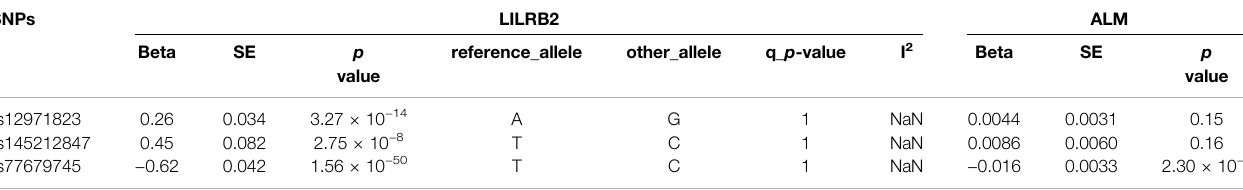
TABLE 1 | Correlation of genetic IVs to LILRB2 and ALM. SNPs